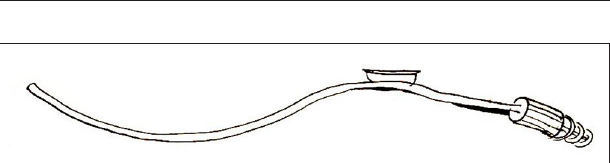
FIGURE 2 | The flask-shaped bone window for neuroendoscopic removal of the subdural hematoma.